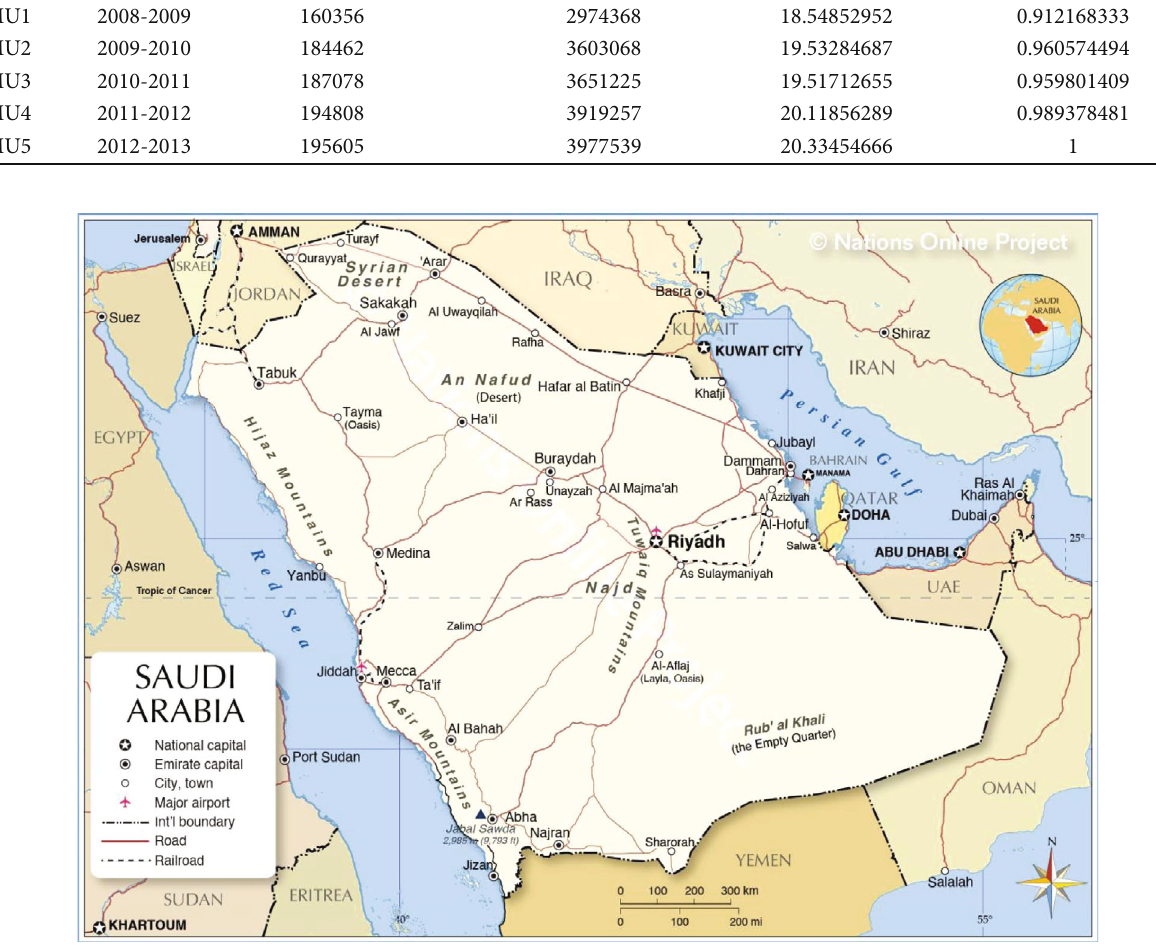
Figure 1: Study area of this research [34, 35]. Table 2: The relative e ffi ciency scale of output